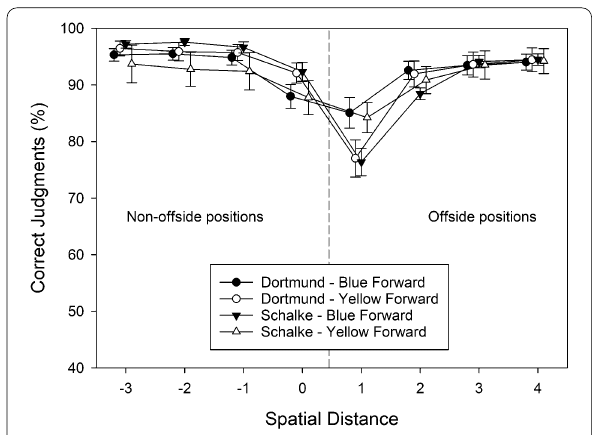
Fig. 6 The percentage of correct offside judgments observed in Experiment 2, plotted as a function of spatial distance (between forward and defender), participants’ team preference (Dortmund vs. Schalke), and shirt color of the attacking team (blue vs. yellow). Error bars represent standard errors between participants. For each level of spatial distance, data points are jittered to increase